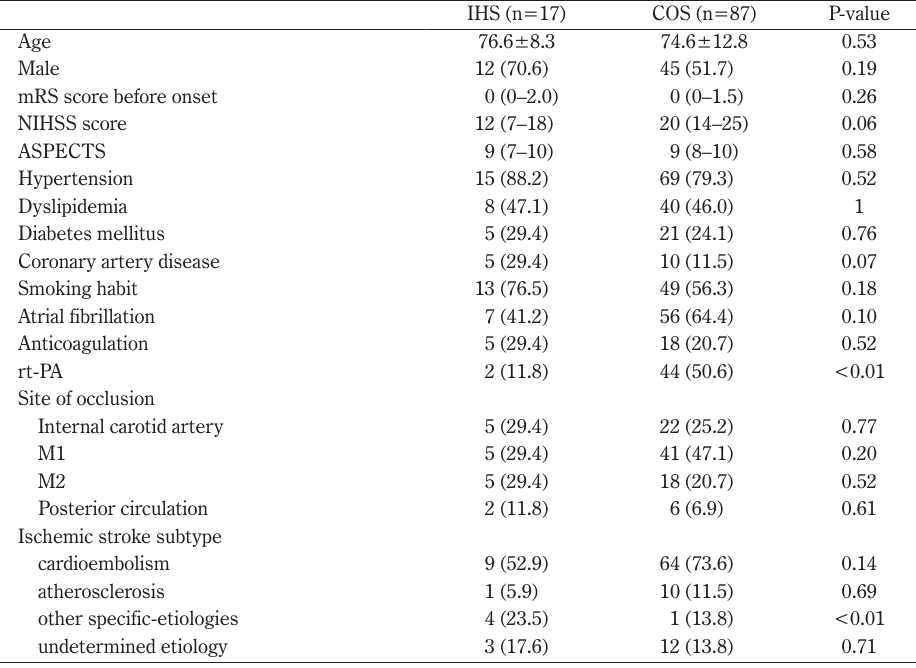
Table 1 Characteristics of patients with in-hospital stroke and community-onset stroke